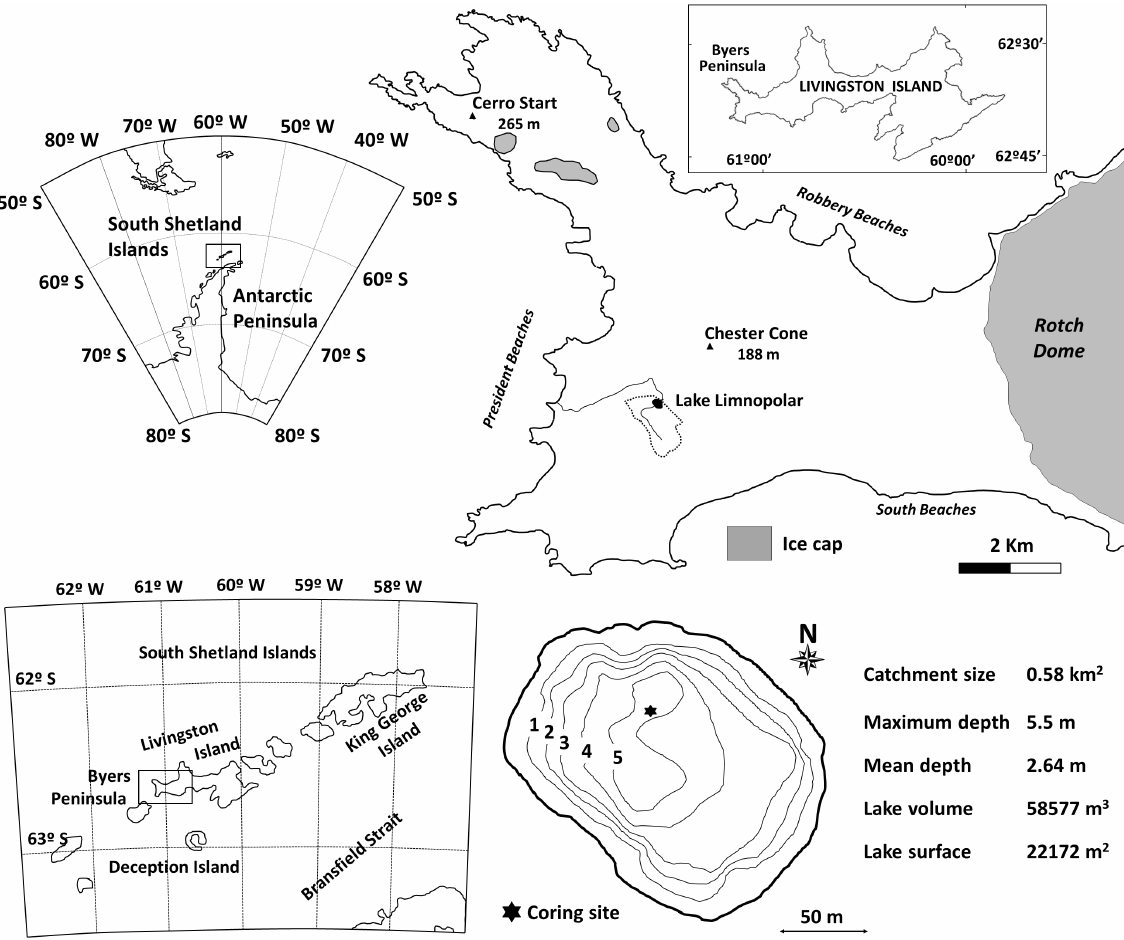
Figure 1. Location of Limnopolar Lake on Livingston Island (South Shetland Islands, Antarctica). Modified from Toro et al.